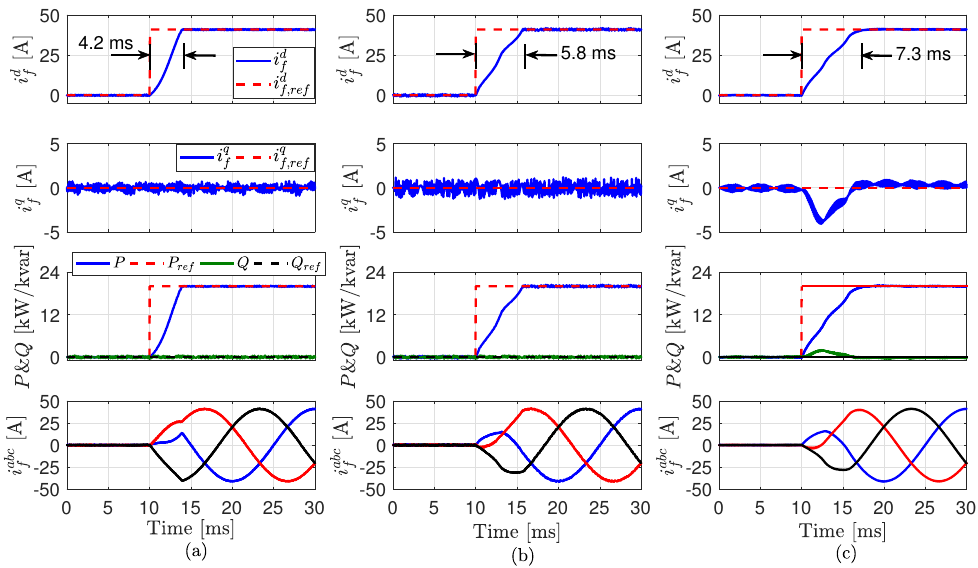
Figure 7. Dynamic performance of the different control techniques: ( a ) proposed DMPC, ( b ) traditional DMPC, and ( c ) VOC.